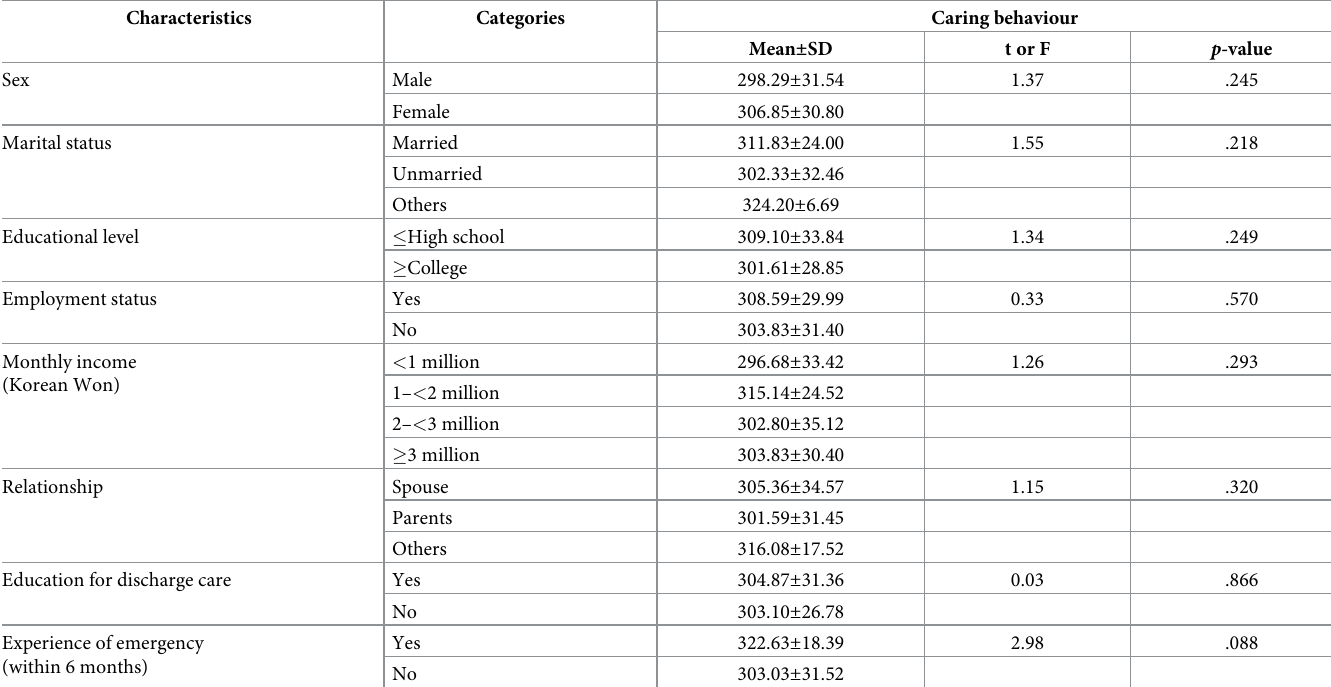
Table 4. Difference of caring behavior scores by characteristics of family